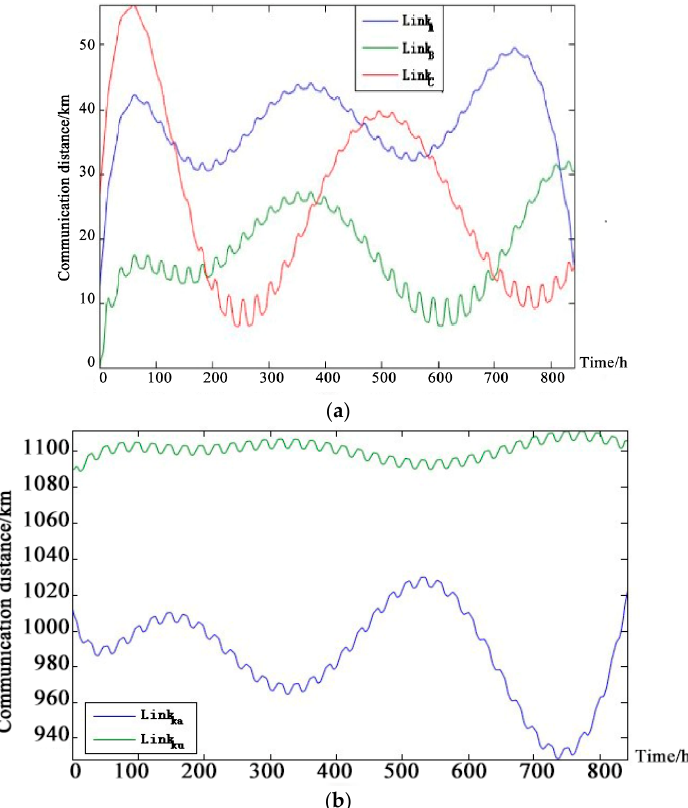
Figure 7. Directed acrylic graph of a solar-powered UAV data-link system.